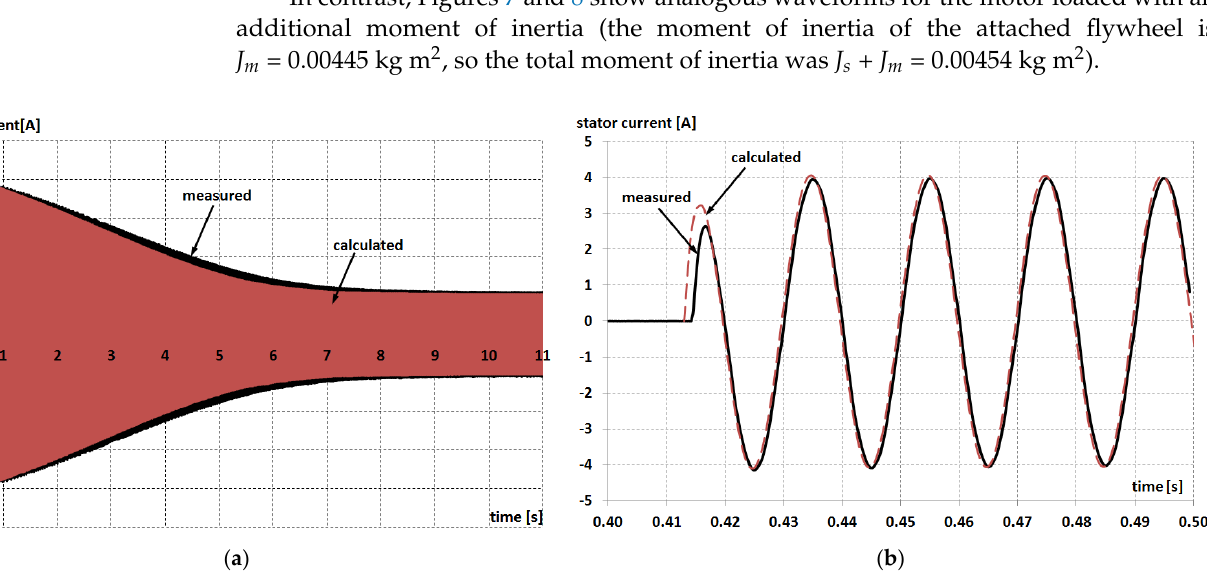
( b ) Figure 8. Measured and calculated time waveforms of the instantaneous value of the torque ( a ) and rotor speed ( b ) during direct motor starting when supplied from the mains with a voltage of 50 Hz, for the motor with additional inertia mass ( J = 0.00454 kg m 2 ). As shown in Figures 5–8, the applied mathematical model gives excellent compliance of the calculation results with the measurement results. For direct motor start-up when powered by the voltage with the mains frequency (50 Hz), the discrepancy between the measured and calculated first current amplitude is (3.37–3.21)/3.37 × 100 = 4.75%, while the discrepancy between the measured and calculated first torque amplitude is (0.555 − 0.547)/0.547 × 100 = 1.45%. The measured and calculated rotational speed rise time is prac- tically the same. Figures 9 and 10 show the measured and calculated motor start-up waveforms with a frequency start up to a frequency of 300 Hz, with an initial voltage of zero and a fre- quency rise time of 2 s for the motor with additional inertia mass ( J = 0.00454 kg m 2 ).